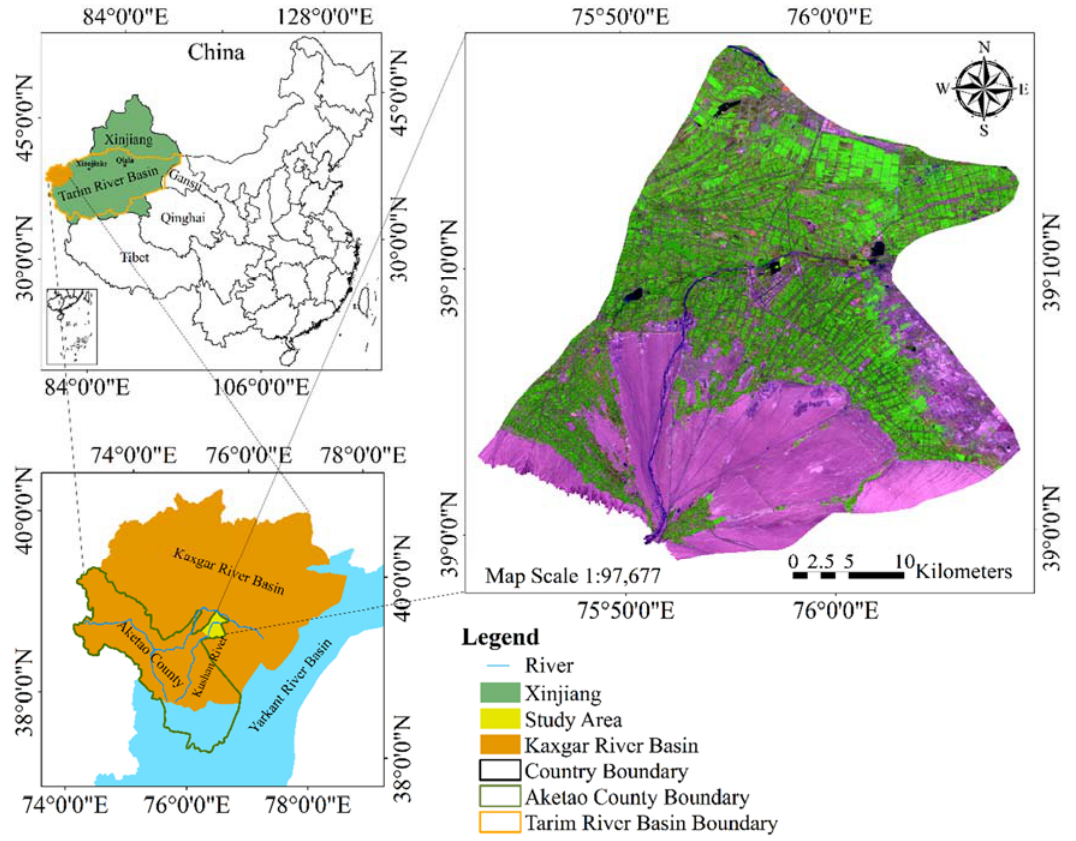
Figure 1. Map of the study area.